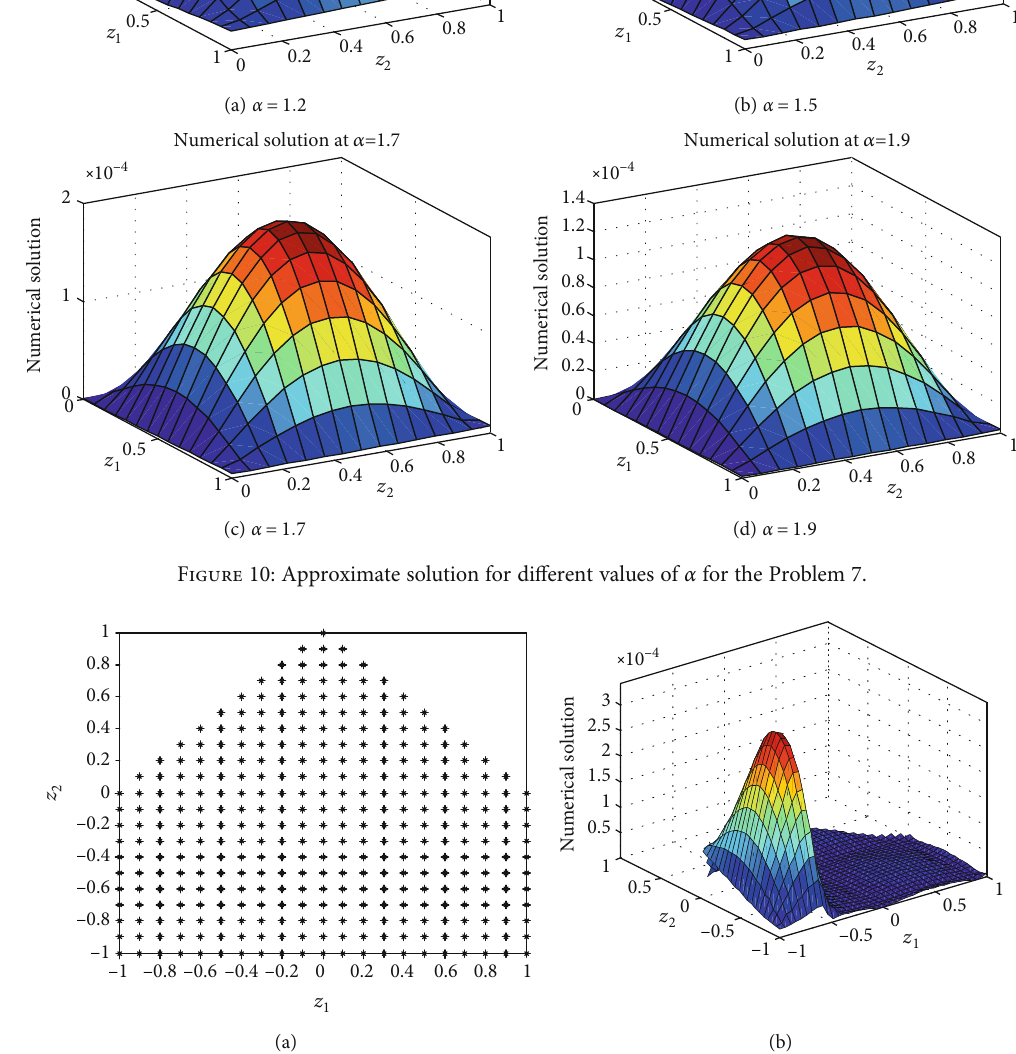
Figure 11: (a) Irregular domain and (b) absolute error for Problem